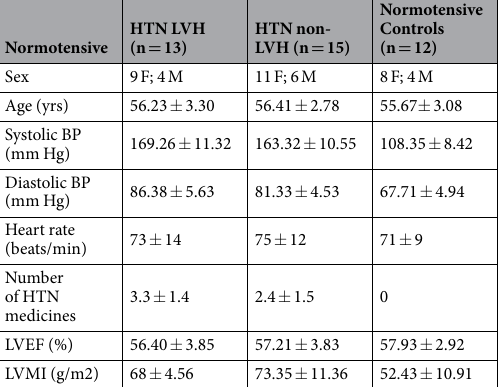
Table 1. Baseline Characteristics of HTN LVH, HTN non-LVH and Normotensive Controls.